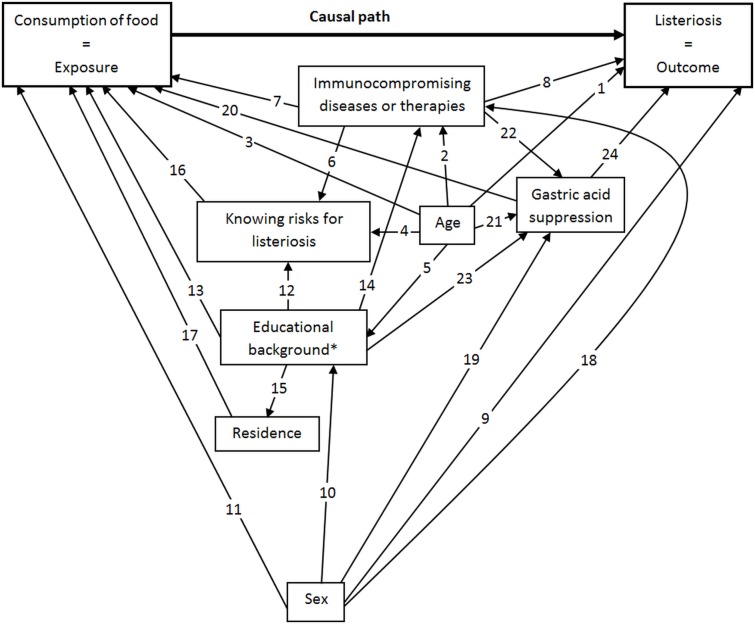
Hypothesized causal structure of exposure, host factors and non-pregnancy associated listeriosis, Germany, 2012–2013 [48–61].* Proxy for socio-economic status
Presumed causal relationships based on:
Significant associations in scientific studies1 Age-related changes of the immune system (immunosenescence) lead to increased susceptibility to infections [48] in general; risk for listeriosis increases with age [49]2 Prevalence of chronic health conditions in Germany increases with age [50]3 Dietary behavior of German adults depends on age [51, 52]5 Socioeconomic status depends on age in a highly representative sample of the German population [13]8 Presence of an underlying immunocompromising disease or therapy increases risk for listeriosis [24, 25]9 Experimental evidence suggests increased susceptibility for listeriosis in male animals [53]10 Socioeconomic status depends on sex in a highly representative sample of the German population [13]11 Dietary patterns among German adults differ between the sexes [51]13 Socioeconomic status influences nutrition pattern [54]14 Health (morbidity) is related to socioeconomic status in highly representative samples of the German population [55]18 Morbidity is related to sex in highly representative samples of the German population [50]19 Prescription of gastric acid suppressors is related to sex in Germany [56]21 Prescription of gastric acid suppressors is related to age in Germany [56]23 Prevalence of reflux symptoms (indication for gastric acid suppression) is significantly associated to socioeconomic status in a highly representative sample of the German population [57]; chronic use of gastric acid suppressors is associated with low income and low educational level [58]24 Gastric acid suppression lowered infectious dose of L. monocytogenes in animals [59] and was associated with listeriosis outbreak [60]Official Statistics:17 Residence determines access to retailers, food handlers, farmer's markets etc. (www.lbv.brandenburg.de/dateien/stadt_wohnen/rb_Einzelhandel_Brandenburg_2011.pdf; last accessed on 18.12.2014)Assumptions:4 Knowledge about listeriosis depends on age (e.g. by lifelong learning, age-dependent access to electronic media)6 People with underlying disease are better informed about listeriosis through physicians or self-study7 Consumption pattern of people with underlying immunocompromising diseases or therapy differ from those of healthy people (food intolerances, special diets etc.)12 People with higher SES (educational background) are better informed about listeriosis15 SES influences choice of residence16 Susceptible persons who know listeriosis tend to avoid consumption of risk foods20 Consumption pattern of people with gastric acid suppression differ from those of people without (weight loss diet is recommended as non-drug treatment for reflux diseases in German treatment guidelines)22 High level of (inappropriate) prescriptions of gastric acid suppressors for hospitalized patients are continued in primary care [61]